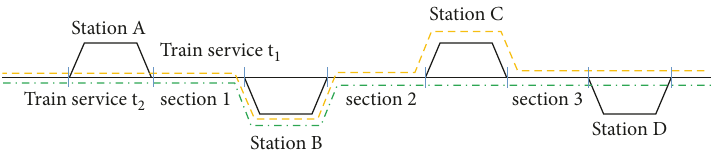
Figure 1: Example of the layout for timetable